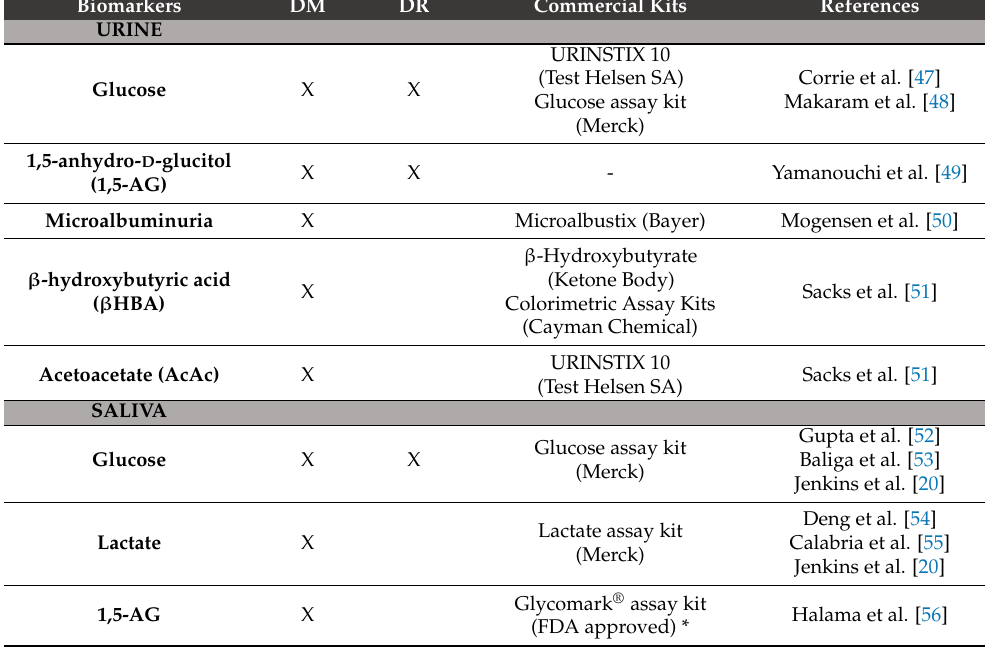
Table 1. Biomarkers related to DM and DR found in urine, saliva, sweat and tears, along with some commercial kits exploiting